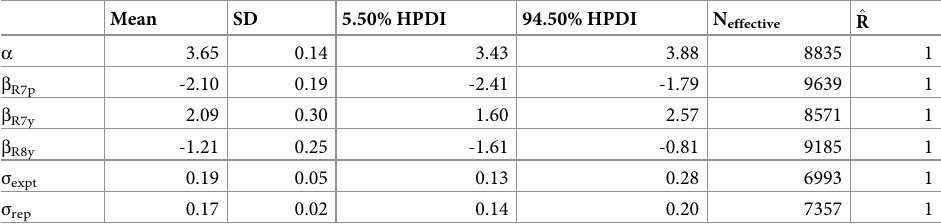
Table 7. A summary of posterior distributions for the coefficients estimated by analysis of the data collected by [4].